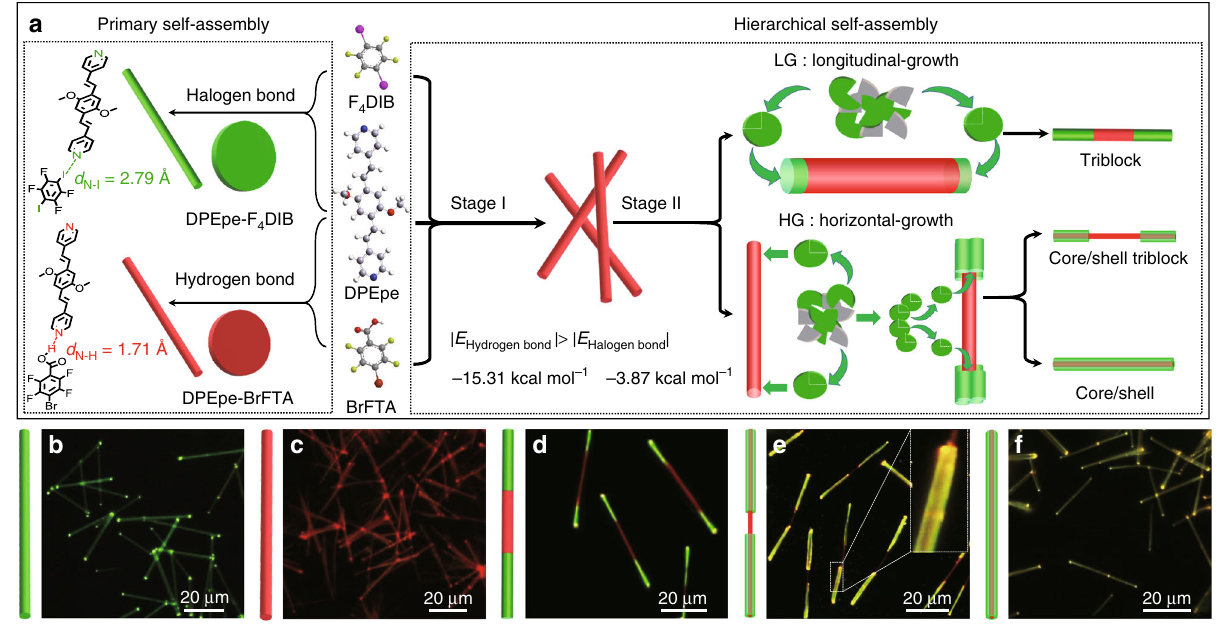
Fig. 1 Illustration of the hierarchical self-assembly for 1D OHSs. a Schematic illustrations: the primary self-assembly of halogen-bonded DPEpe-F 4 DIB cocrystal and hydrogen-bonded DPEpe-BrFTA cocrystal; the hierarchical self-assembly of organic TNWs, DB-C/S-NWs, and organic C/S-NWs. b – f FM images of these as-prepared b halogen-bonded DPEpe-F 4 DIB cocrystals, c hydrogen-bonded DPEpe-BrFTA cocrystals, d organic TNWs, e organic DB-C/S- NWs and f organic C/S-NWs excited with the UV band ( λ = 330 – 380 nm) from a mercury lamp. Scale bars are all 20 μ m. Inset of ( e ): the magni fi ed image of a typical tip in DB-C/S-NWs, clearly showing the core-shell